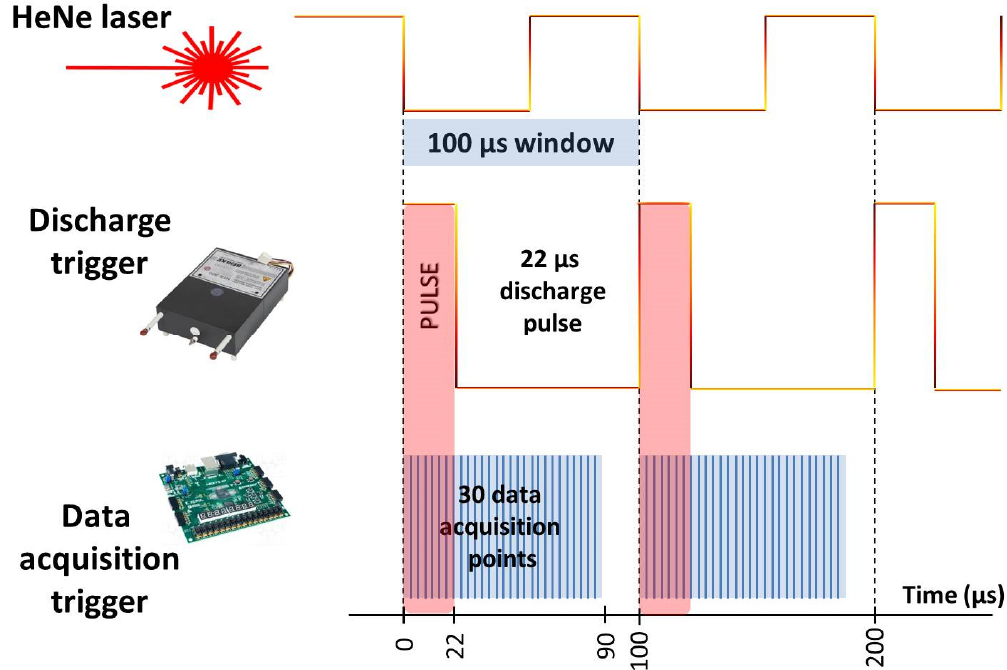
Figure 3. Time-resolved data acquisition setup.